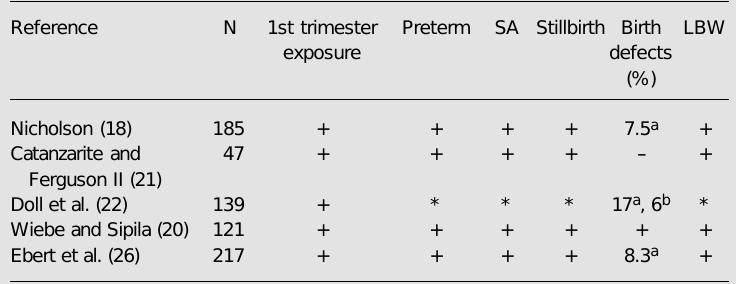
Table 6. Pregnancy outcome for patients with cancer in pregnancy: literature review. Reference